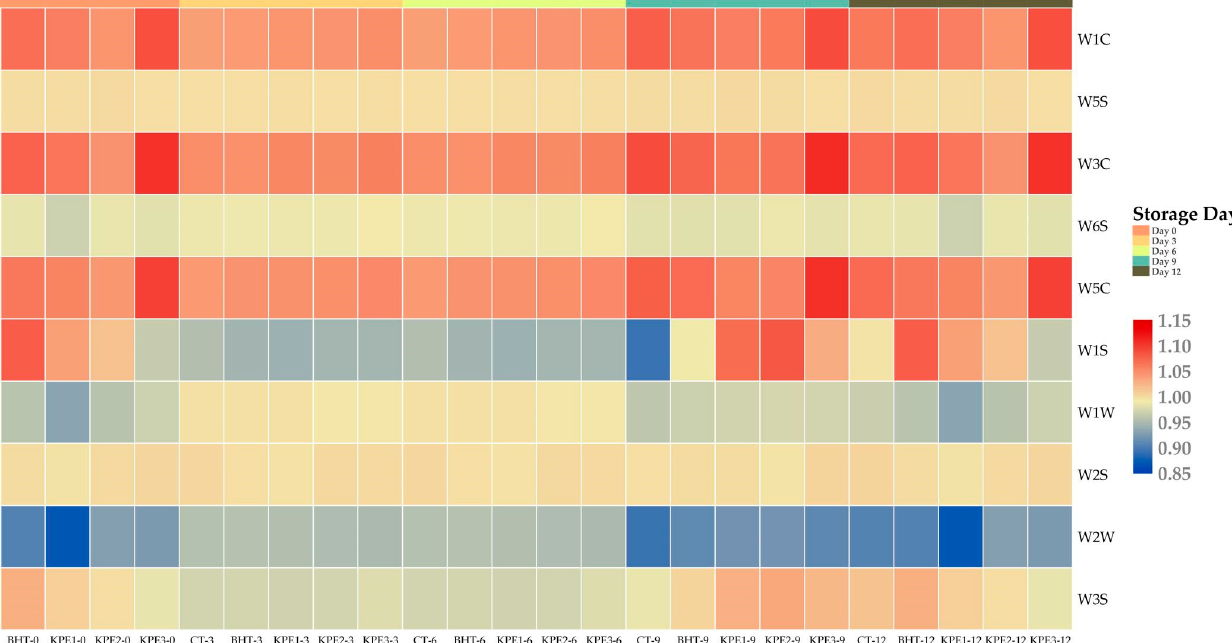
Figure 2. Heatmap of E-nose sensor responses in beef sausages during 12 d of refrigerated storage. CT: (0% KPE), BHT: (0.01%), KPE1: (1.5%), KPE2: (3%), and KPE3: (4.5%) stored at 4 ± 1 °C for 12